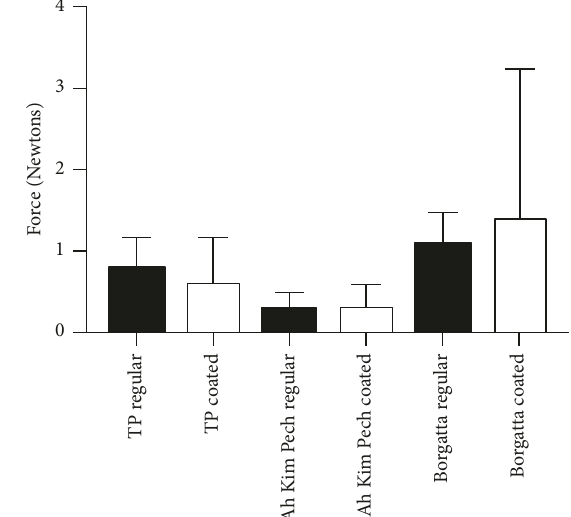
Figure 5: Comparison of the mean force (N) of the permanent deflection between round 0.016 󸀠󸀠 regular and coated Ni-Ti wires. There was no statistically significant difference between the coated and regular Ni-Ti wires from the three manufacturers; nevertheless, there was a statistically significant difference between the coated TP and the Ah Kim Pech and Borgatta Ni-Ti wires ( 𝑝 < 0.01